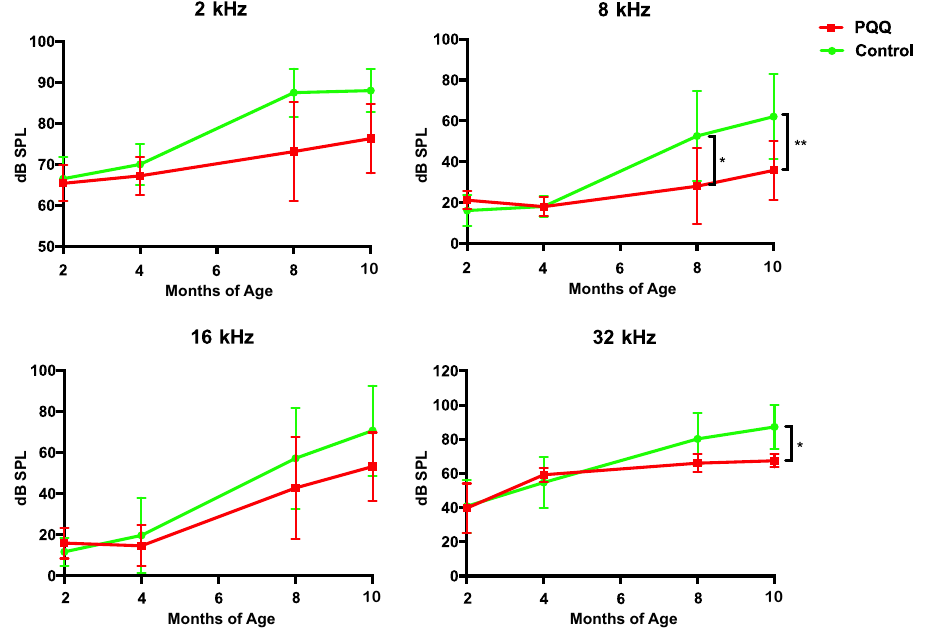
Figure 5. ABR thresholds in the age-related hearing loss model ABR thresholds of each frequency (4 kHz, 8 kHz, 16 kHz and 32 kHz) at each month of age. There were significant differences between the PQQ and control groups at 8 kHz and 32 kHz at 10 months of age. * p < 0.05, ** p < 0.01. (Control group ( n = 10) and PQQ group ( n =